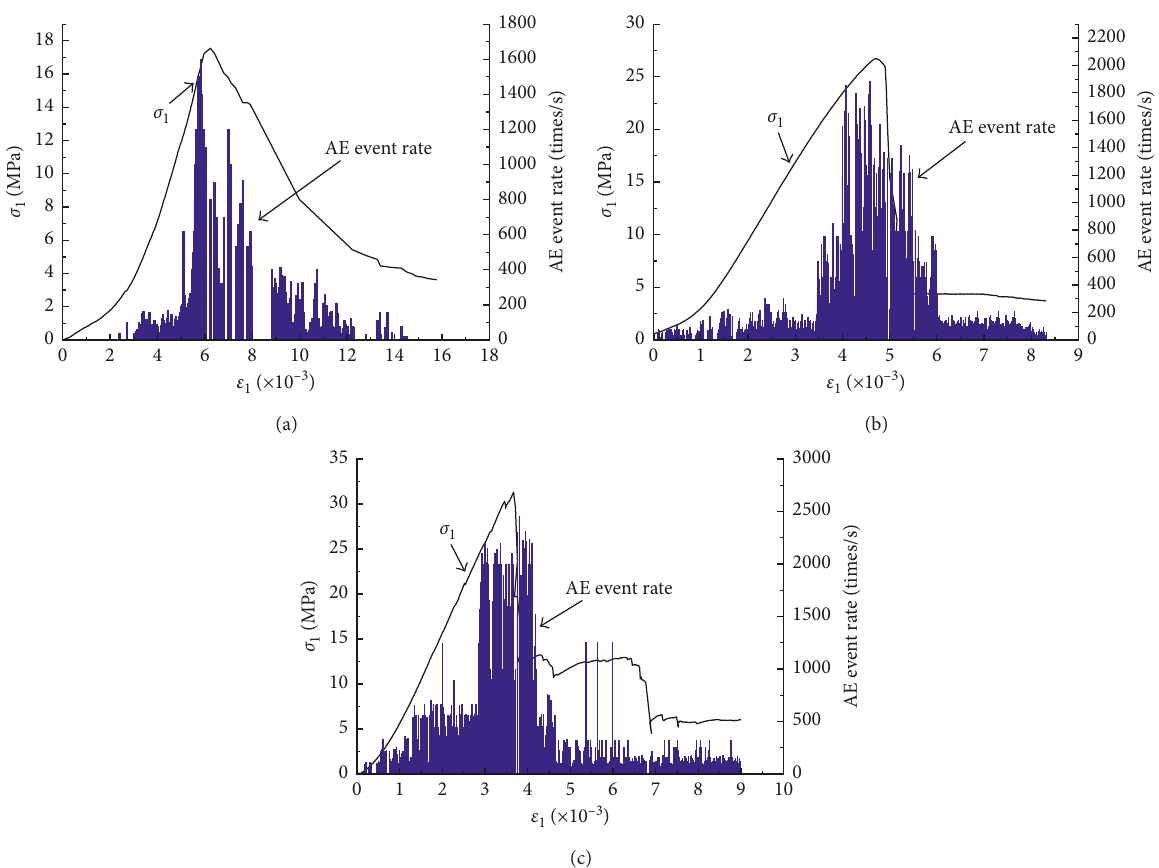
Figure 9: Variation curves of AE event rates for mudstone samples with different moisture content under uniaxial compression. (a) Soaked sample. (b) Natural sample. (c) Dry sample.